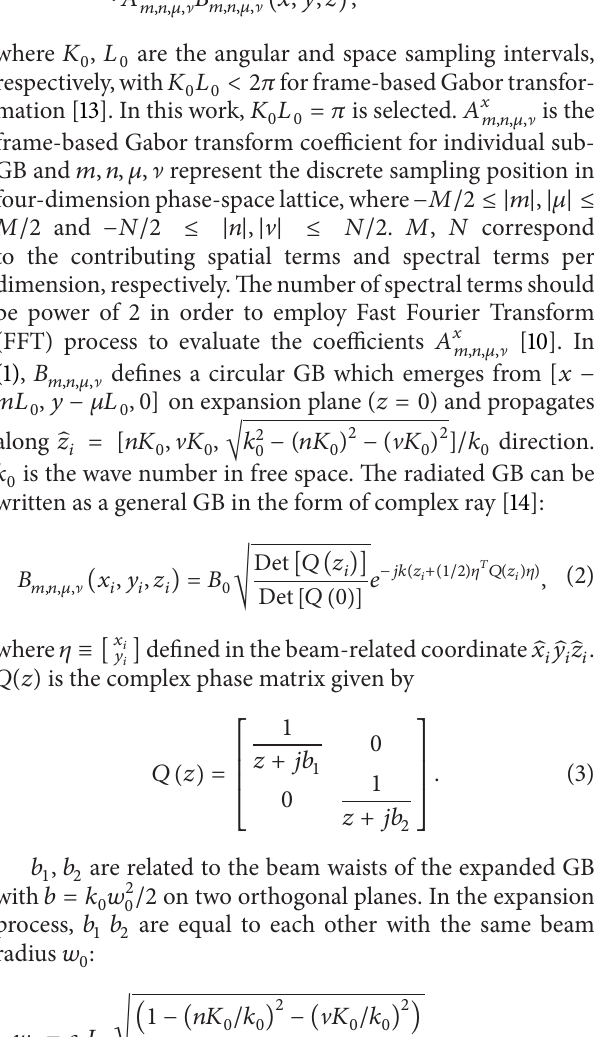
Figure 1: Scheme of frame-based Gabor transformation.